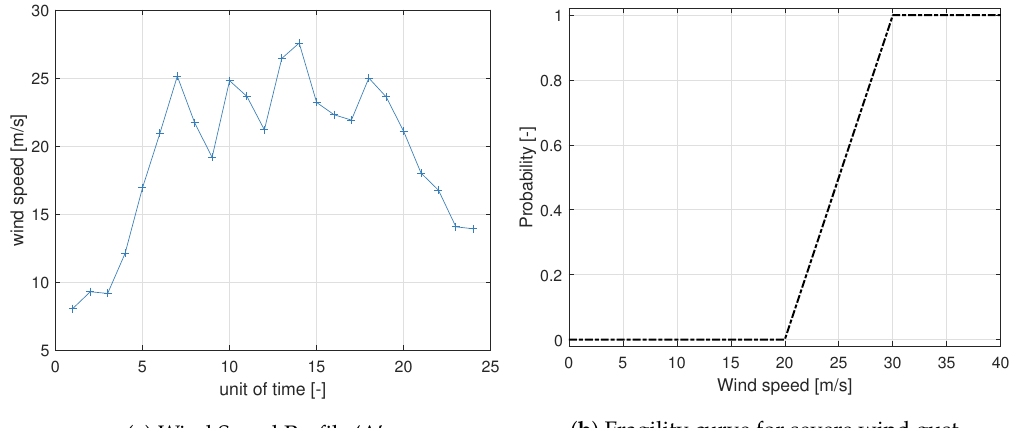
Figure 2. Failure